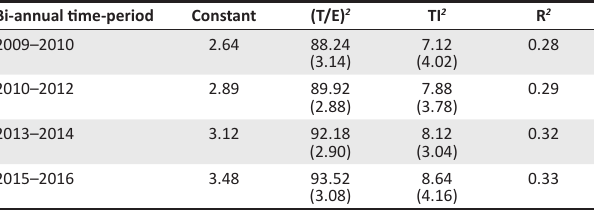
FIGURE 2: Percentage change in employee productivity.